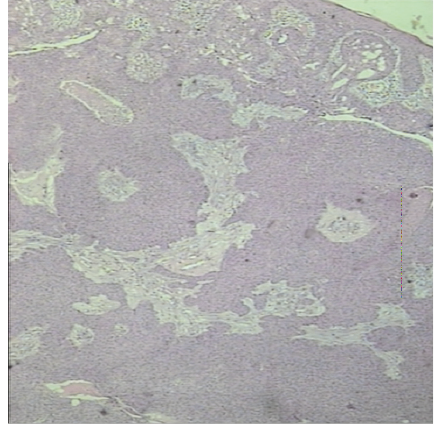
Figure 2: Histological examination of the tumor revealed mixed character of eccrine poroma and poroid hidradenoma (H&E × 25).